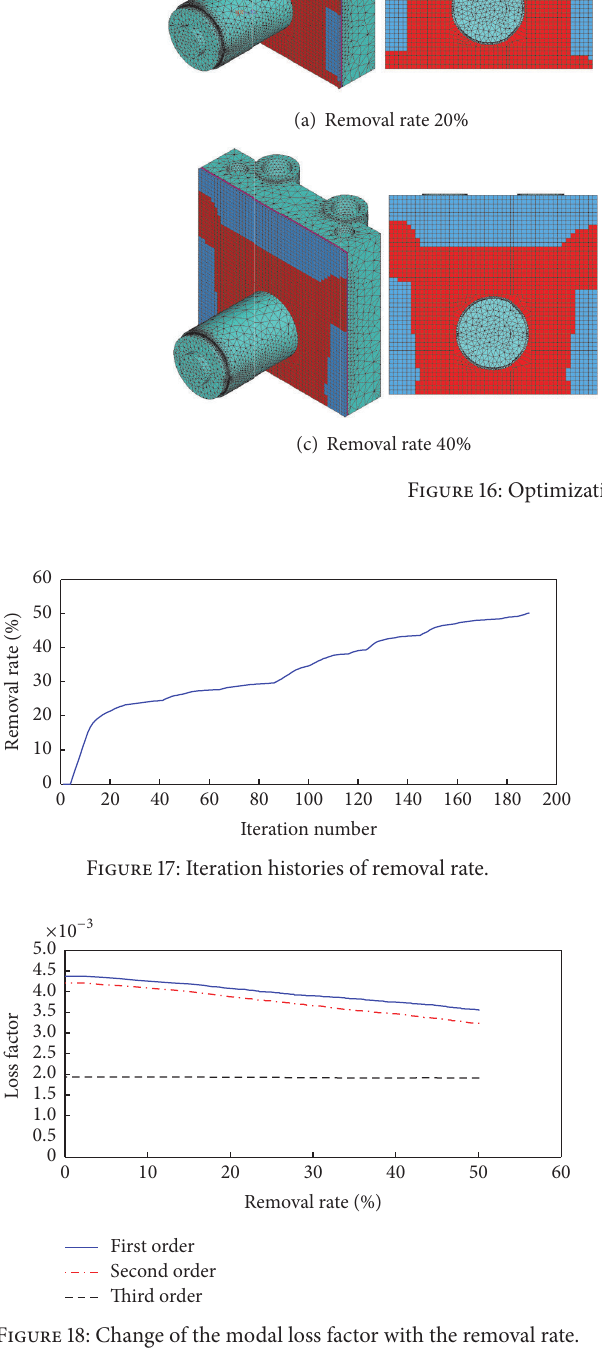
loss factor. The optimization results indicate that the added weight of damping material decreases by 50%, and the